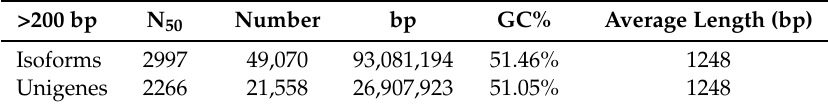
Table 2. De novo assembly results using Trinity.